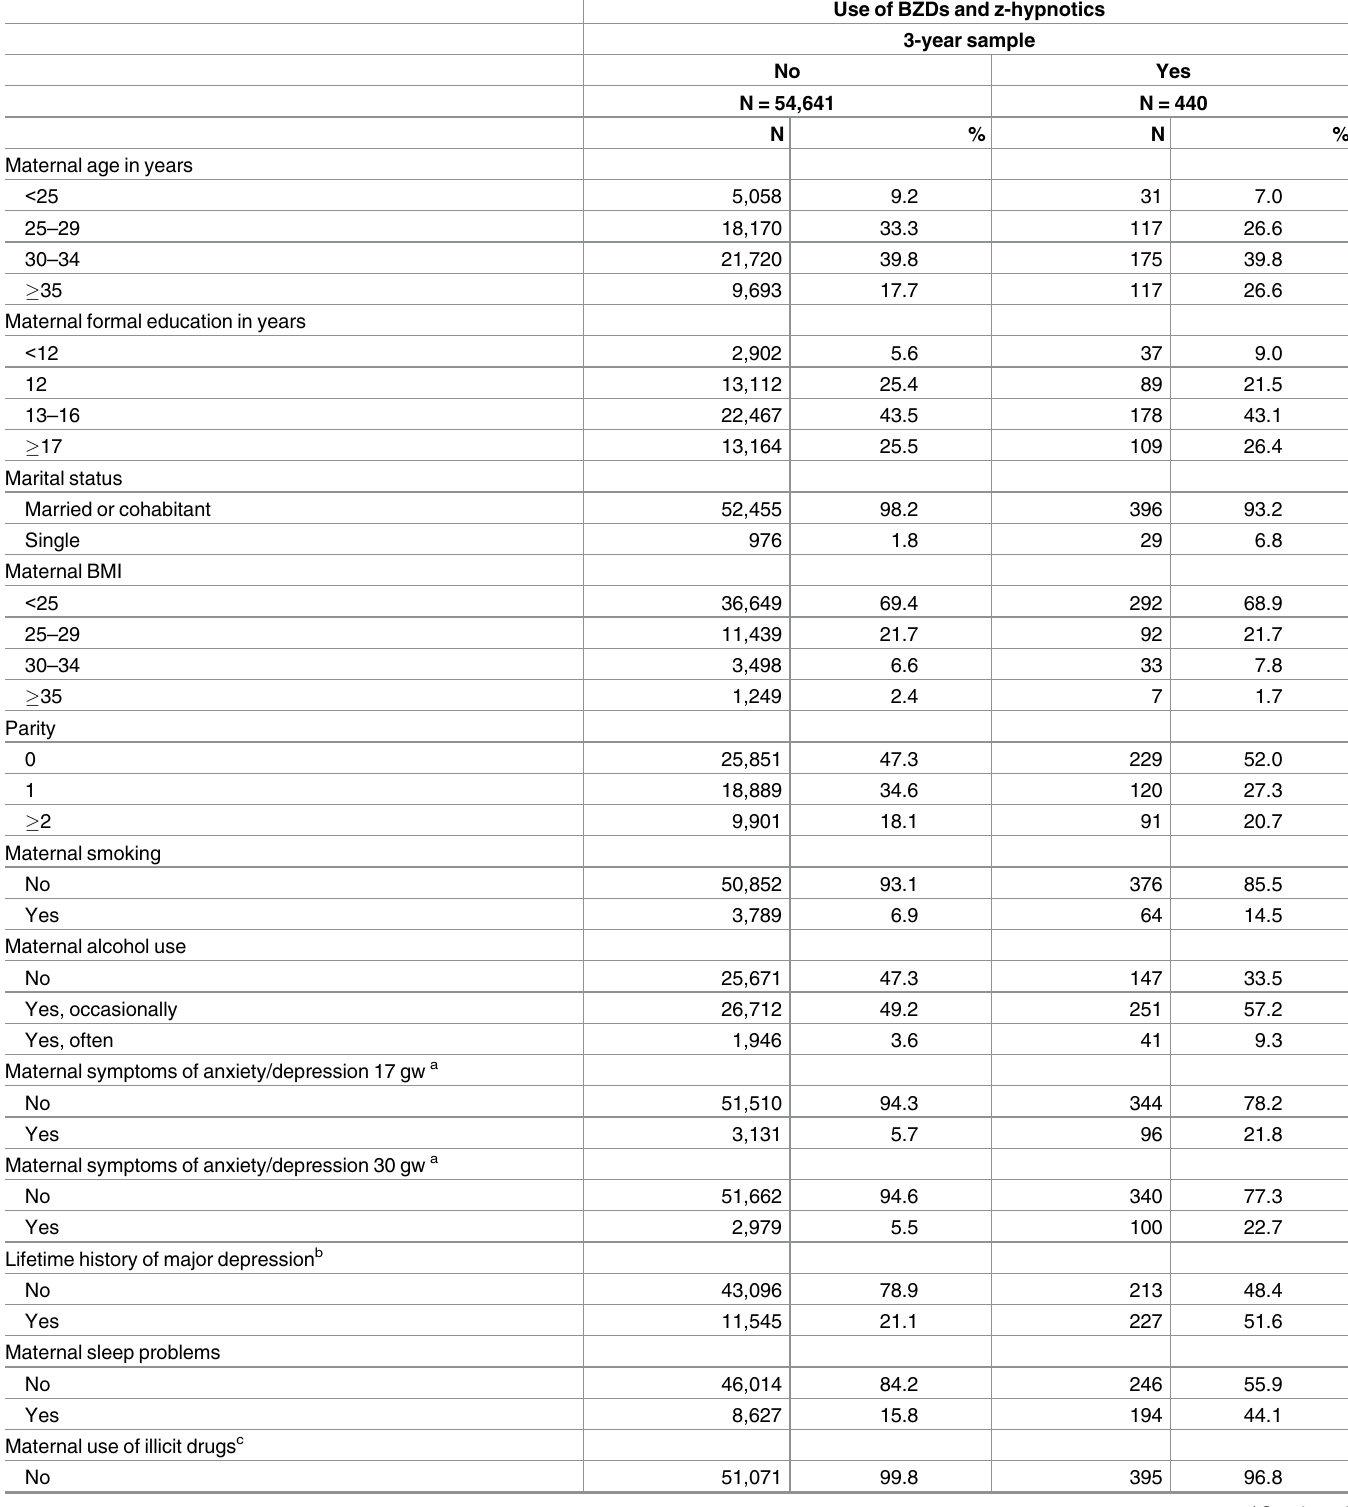
Table 3. Maternal characteristics by use of BZDs and z-hypnotics during pregnancy in the 3-yearMoBa sample.